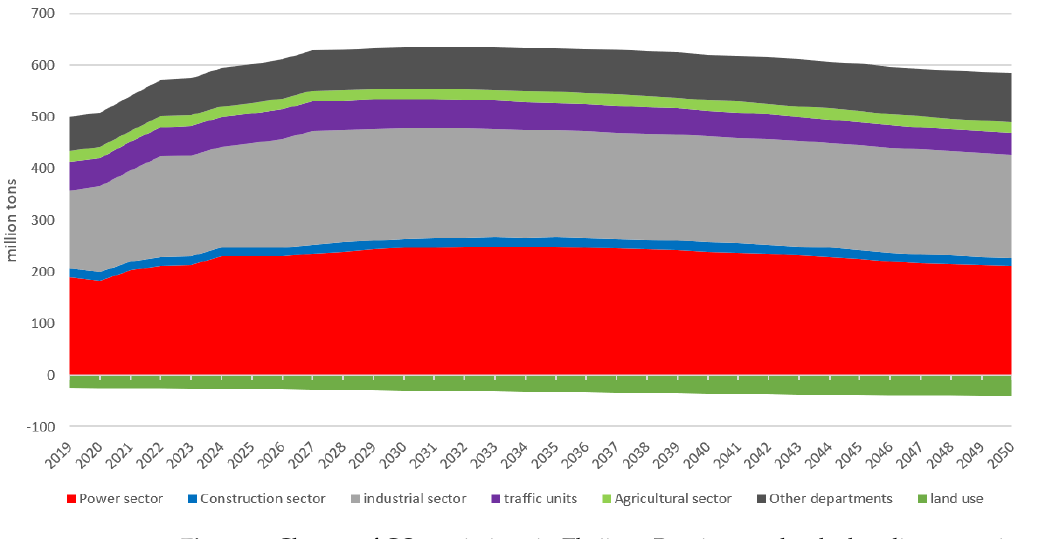
Figure 5. Change of CO 2 emissions in Zhejiang Province under the baseline scenario.